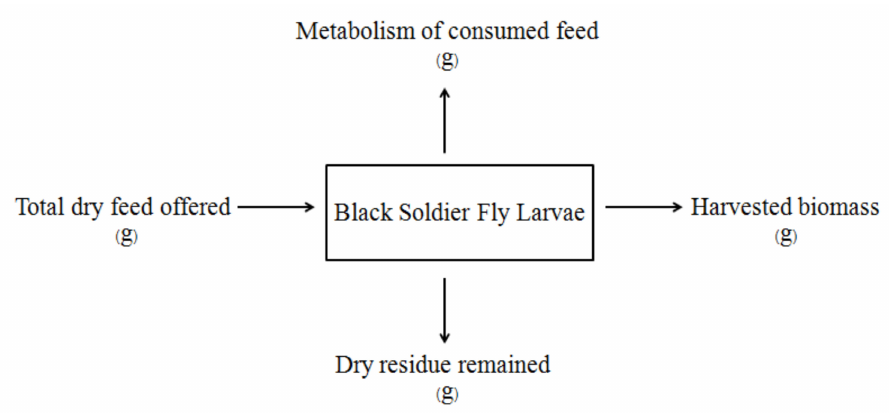
Figure 1. Mass balance model of valorization of blended sewage sludge with palm kernel expeller (PKE) via bioconversion into the biomass of black soldier fly